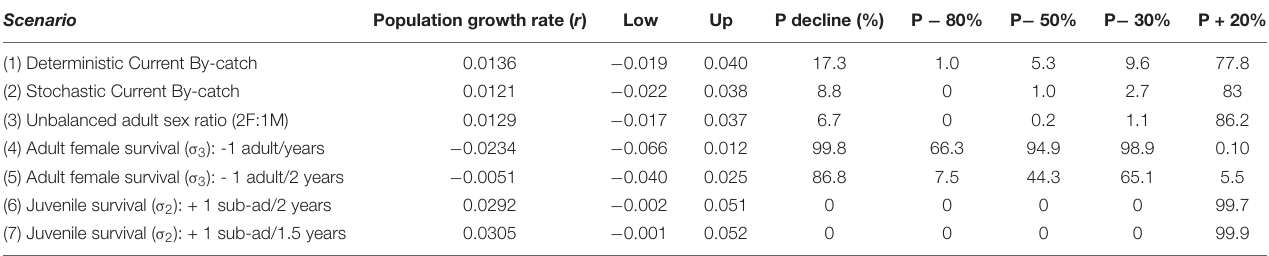
TABLE 2 | Results of simulations used to estimate the growth rates and viability of the Patos Lagoon estuary’s Lahille’s bottlenose dolphin population under several scenarios of by-catch.